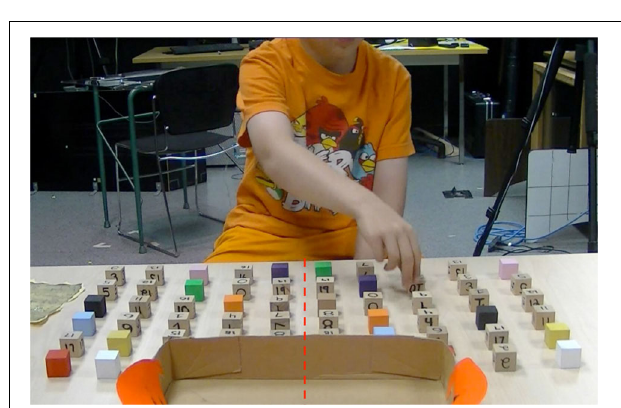
FIGURE 2 | An illustration of the workspace in the grasp-to-place task. The table was notionally divided into left and right space; 2 identical sets of 20 numbered and 10 colored blocks were placed in left and right space in near-mirror image positions that remained consistent across participants. The experimenter called out a pseudo-random list of numbers and colors; after each, the child was to locate one correspondingly-labeled block as quickly as possible, and place it into the box at the far end of the array (the “monster’s